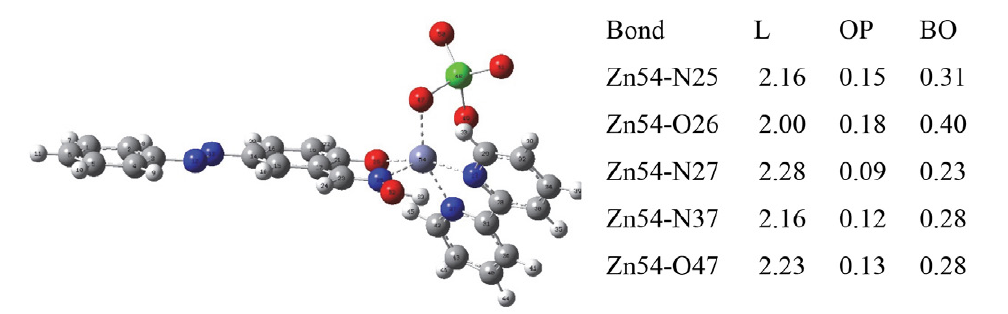
Serbest et al.: Ternary Transition Metal Complexes with an ...